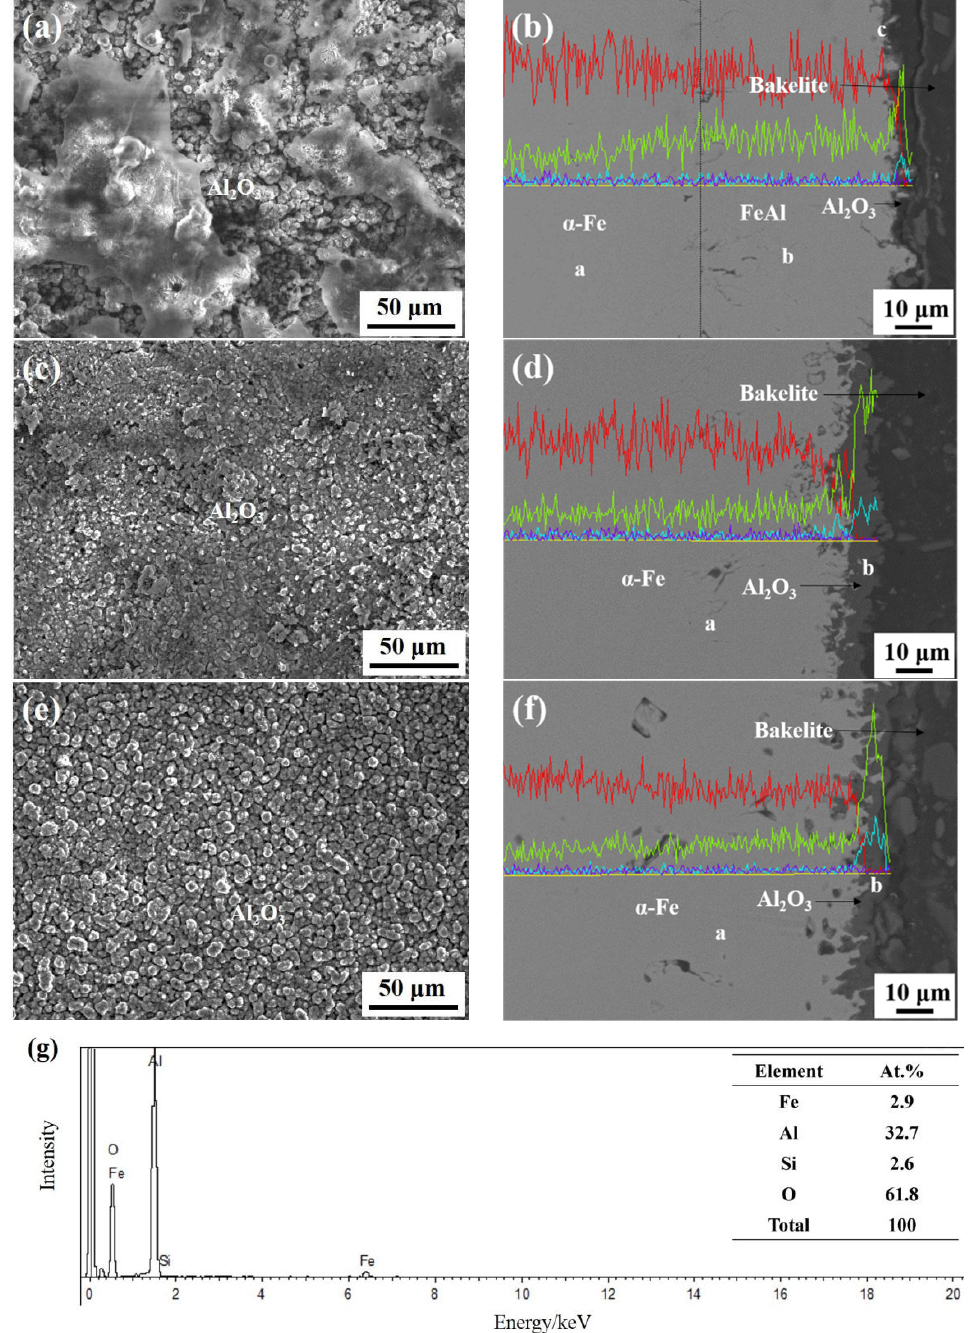
Figure 6. Surface morphology and cross-sectional microstructure of Q345 steel and its corresponding EDS line profiles of elements Fe (red line), Al (green line), O (blue line), and Si (purple line) distributions across the coating layer on the steel substrate after oxidation at 900 ◦ C for 15 h with different preoxidation heat treatment. ( a , b ) Oxidation directly after hot dip in Al-2.5Si; ( c , d ) oxidation after hot dip in Al-2.5Si and annealing at 800 ◦ C for 1 h; ( e , f ) oxidation after hot dip in Al-2.5Si and annealing at 900 ◦ C for 3 h; and ( g ) the typical EDS pattern of the Al 2 O 3